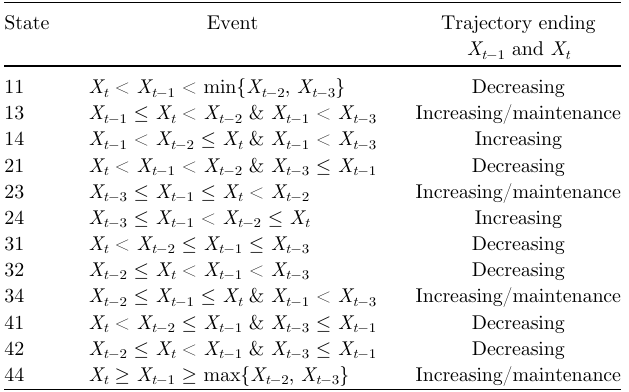
Table 3. d max between the irregular clusters f I 1 ; ... ; I k I 2